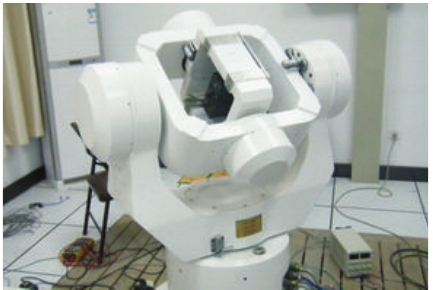
Figure 5: The 3-axis flight motion simulator.